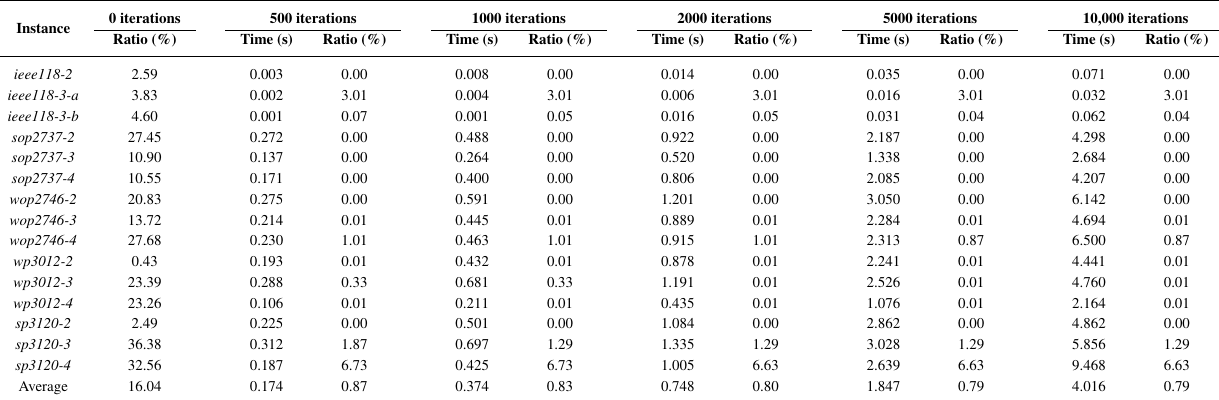
Table 3. Computational results generated by the tabu search algorithm with L = 15